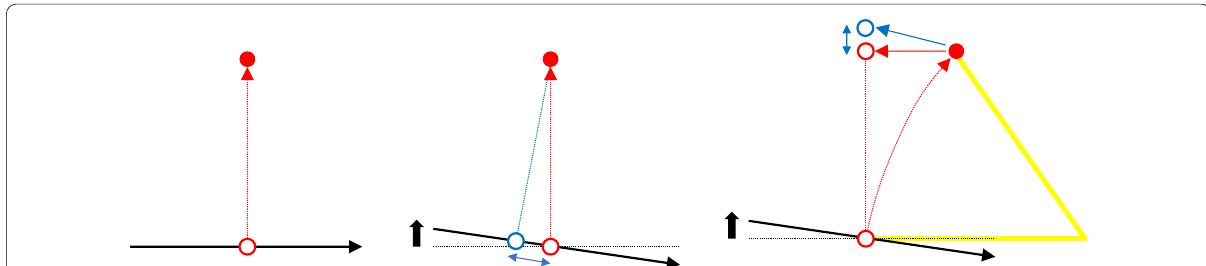
Fig. 9 Complexities associated with the helicorder geometry. a Illustration of a helicorder recording with only rotation. The black line is the trace-zero line that would be produced if the amplitude is always zero. b Same as ( a ) except that this case includes translation that results in the slope of the trace-zero line. If the amplitude is measured perpendicular to the trace-zero line, it will result in an underestimation of amplitude (dashed blue line) and a time offset (open blue circle). c Effect on curvature introduced by pen or needle recording. The arc is generated by instantaneous amplitude change from zero to a maximum value with the armature (yellow lines). The solid red arrow shows how this curvature should be corrected (open red circle) while the blue arrow shows correction if the correction is calculated parallel to the trace-zero line leading to overestimated amplitude (open blue circle)